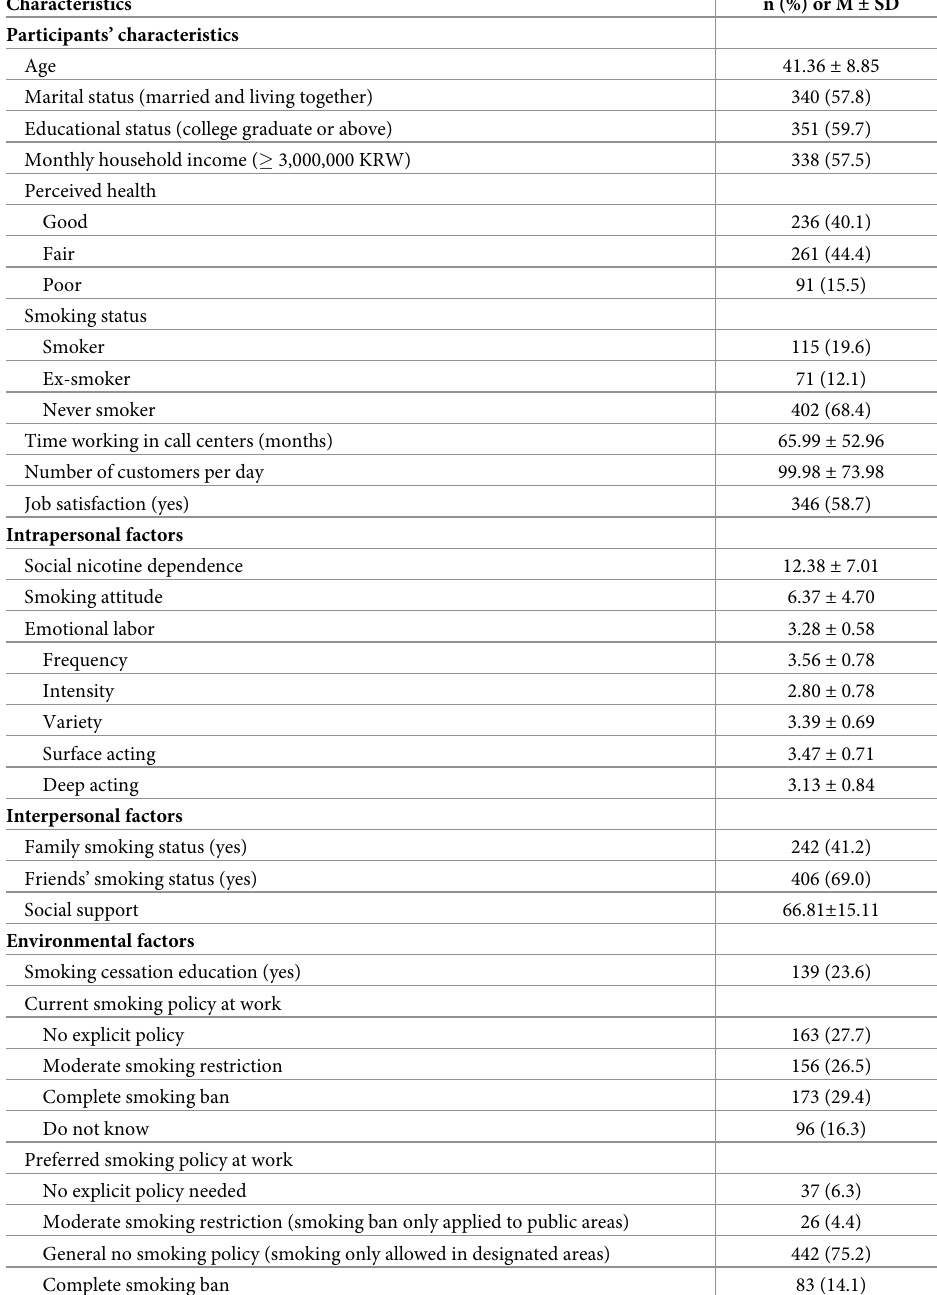
Table 1. Distribution of participants’ characteristics, intrapersonal, interpersonal, and environmental factors (N = 588).